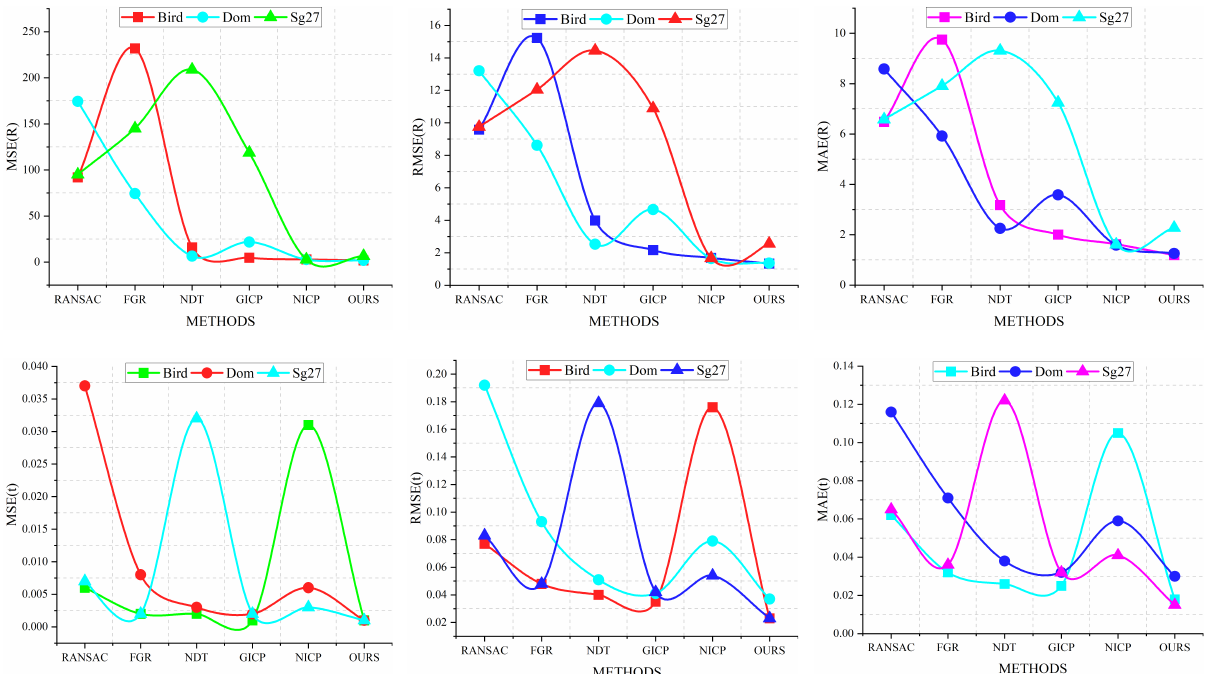
Figure 12. Registration effect comparison. The errors of SJC, CSC, and BSC registered using different methods are measured using MSE, RMSE, and MAE metrics.